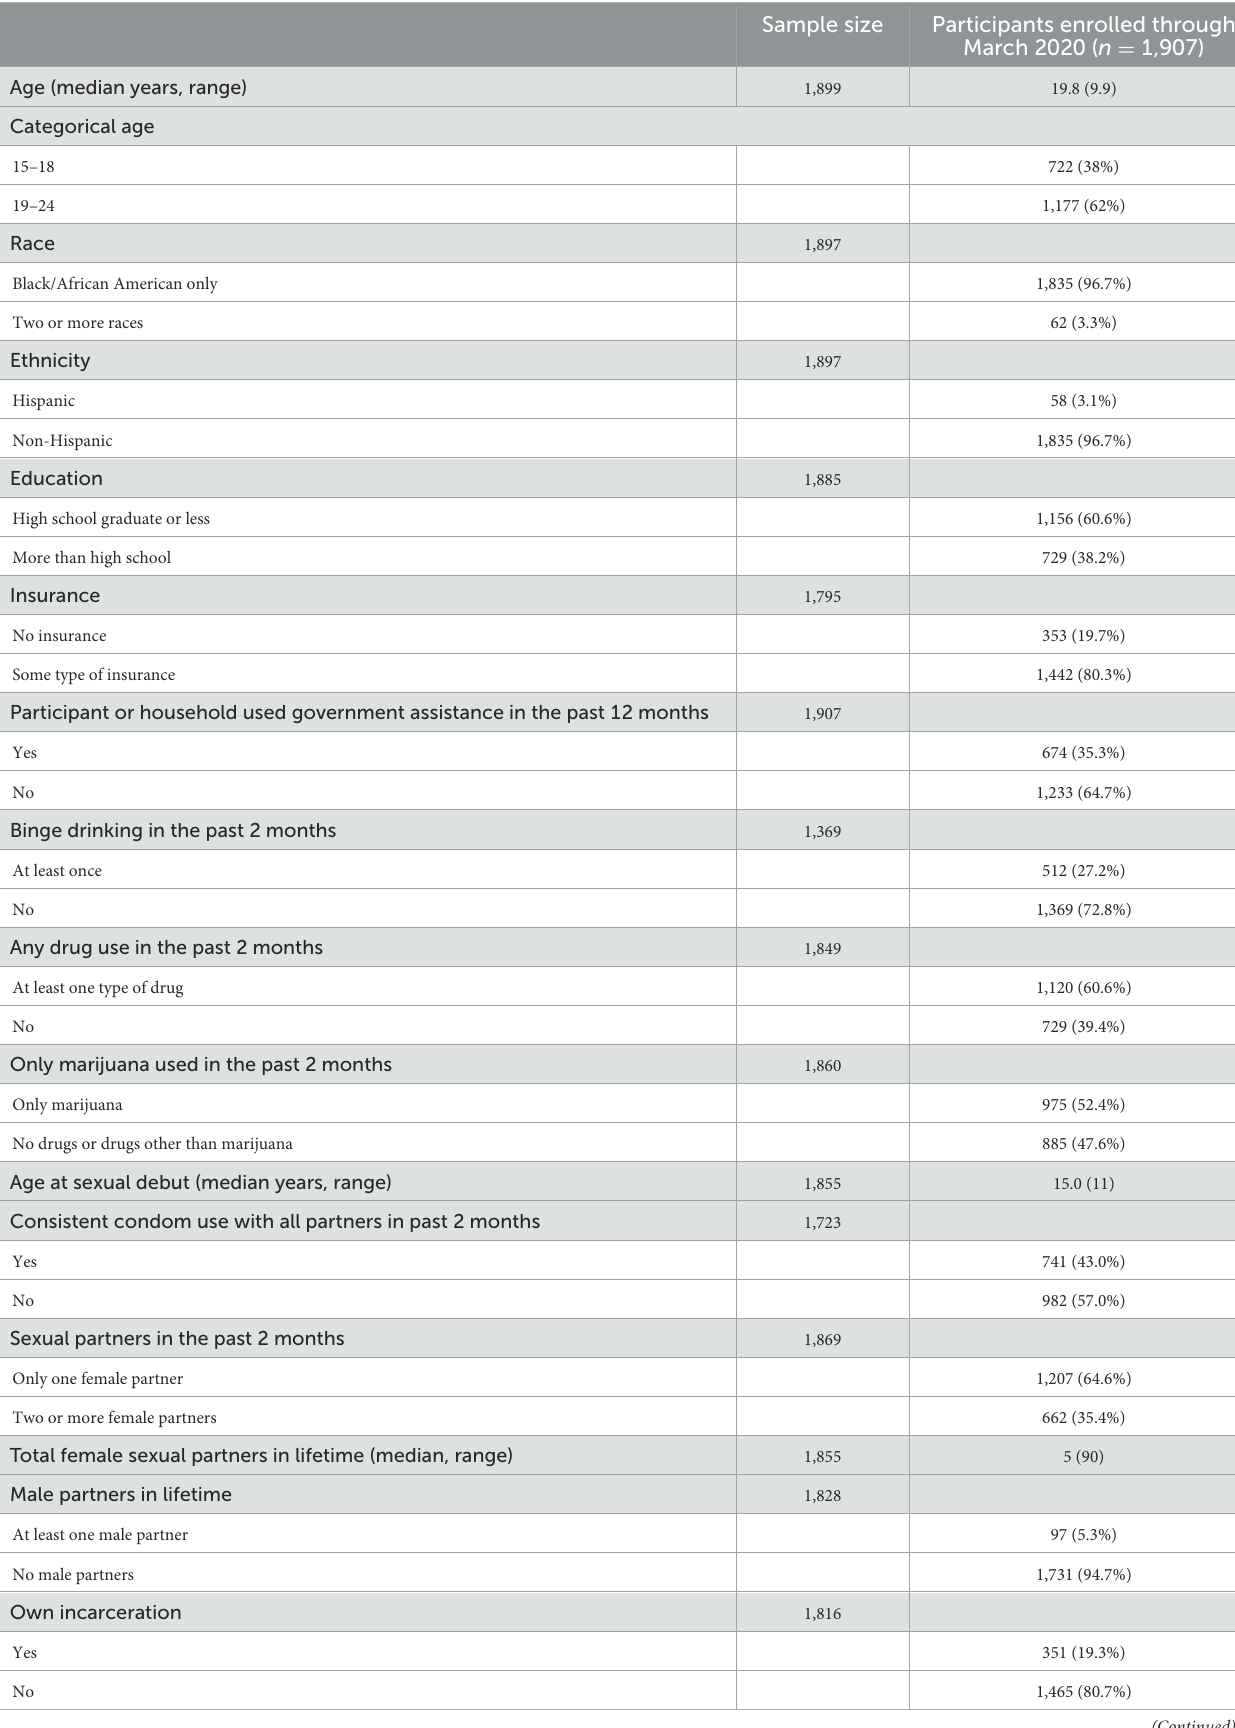
TABLE 1 Characteristics of the Check It cohort enrolled through March 2020 ( n =